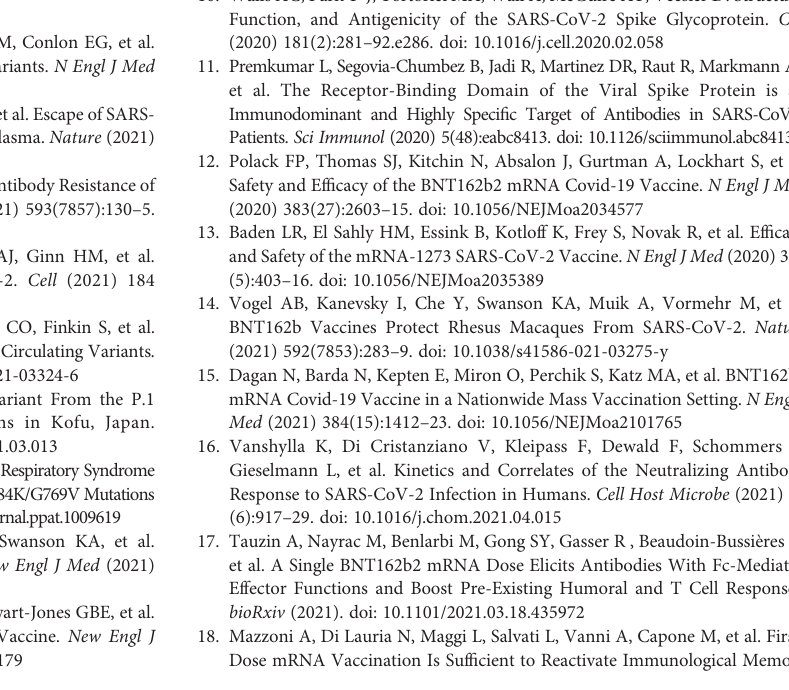
Supplementary Figure 1 | Priming effect of BNT162b2 mRNA vaccine in the infection-naïve individuals. The ratios of antibody titres before vaccination (baseline) and 3 week after the fi rst dose (3 weeks) are indicated. (A, B) Data are shown for (A) age group and (B) gender. A pairwise t-test with Bonferroni correction was conducted for the multiple comparison test across the age groups. Student ’ s t-test was performed for statistical analyses between female (F) and male (M). Supplementary Figure 2 | Changes in anti-nucleocapsid (N) antibody titres in infection-naïve healthcare workers (n=103). Changes in antibody titres after the fi rst vaccine dose fromweek 1 to week 7in 103 healthcare workers (HCWs). The HCWs were seronegative throughout the observation period. COI, cut-off index. The dotted line indicates the cut-off value (1.0 COI). Supplementary Figure 3 | Strati fi ed analysis by age and gender. (A, B) Strati fi ed analysis of males and females in each age group. Data for females are shown in (A) , anddataformalesareshownin (B) . (C – G) Strati fi edanalysisbyageingender.Data are shown for 1 week (C) , 3 weeks (D) , 4 weeks (E) , 5 weeks (F) , and 6 weeks (G) . Student ’ s t-test was performed for statistical analyses between female (F) and male (M). A pairwise t-test with Bonferroni correction was conducted for the multiple comparison test across the age groups. The dotted line indicates the cut-off value (0.8